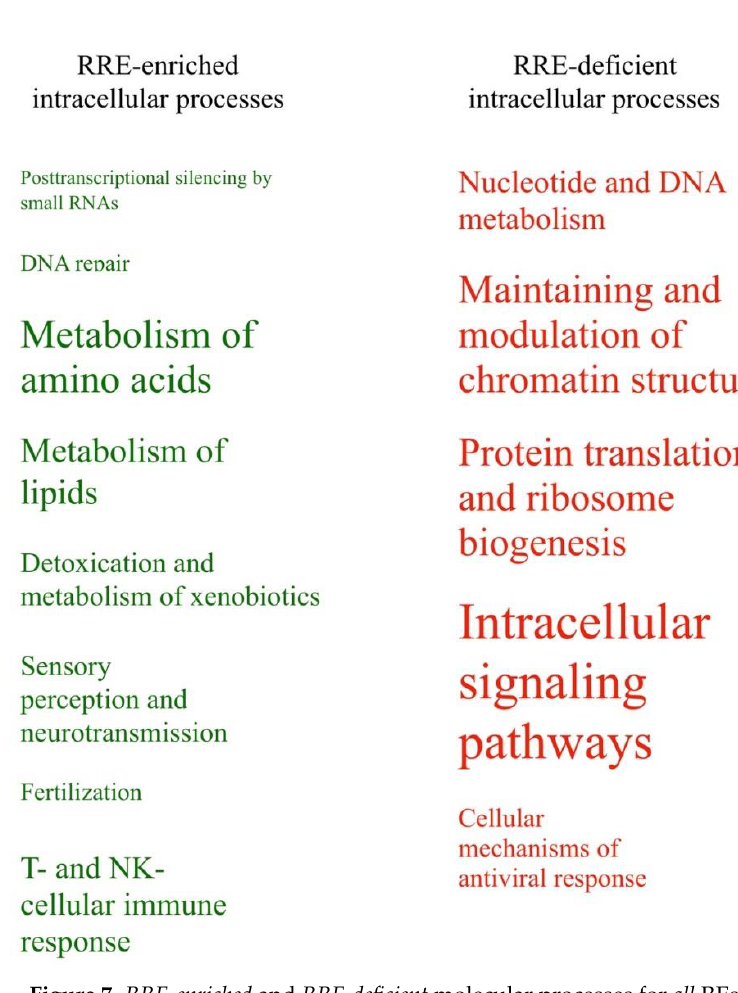
Figure 7. RRE-enriched and RRE-deficient molecular processes for all REs.